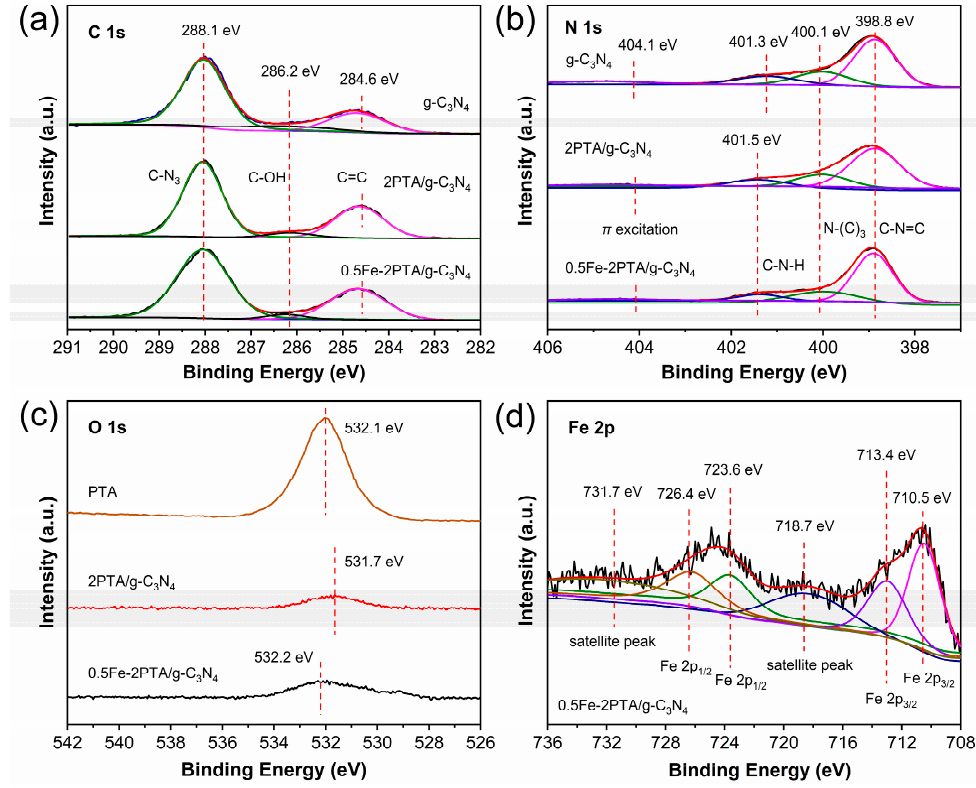
Figure 4. XPS spectra of samples: ( a ) C1s, ( b ) N1s, ( c ) O 1s and ( d ) Fe 2p. As shown in Figure 4c, compared with that of PTA, the O 1s peak of 2PTA/g-C 3 N 4 moves to a lower binding energy, indicating the increased electron density around the O atoms of PTA and confirming the hydrogen bond interaction between the -NH 2 of g-C 3 N 4 and the -COOH of PTA, combined with the above result of the C-N-H peak shift (Figure 4b). Interestingly, compared with that of the 2PTA/g-C 3 N 4 , the O 1s peak of 0.5Fe-2PTA/g-C 3 N 4 exhibits a moderate shift to the higher binding energy direction, indicating the decreased electron density around the O atoms of PTA due to the coordination bond interaction between the introduced Fe(III) and the -COOH of PTA. The interaction between the Fe(III) and the -COOH of PTA was also verified by the O 1s peaks of the PTA and 0.5Fe-PTA in Figure S5b, which clearly shows the O 1s peak shift of the PTA from 532.1 eV to 532.4 eV after introducing the Fe(III) [53]. It is worth noting that in Figures 4c and S5b, the O 1s peaks of the 0.5Fe-2PTA/g-C 3 N 4 and 0.5Fe-PTA are higher than those of the 2PTA/g-C 3 N 4 and PTA, respectively, which is due to the -OH of the introduced Fe(III). The Fe 2p spectra of 0.5Fe-2PTA/g-C 3 N 4 (Figure 4d) can be fitted with Fe 2p 3/2 peaks at 710.5 eV and 713.4 eV and the corresponding symmetric peaks of Fe 2p 1/2 at 723.6 eV and 726.4 eV, respectively, while the peaks at 718.7 eV and 731.7 eV are ascribed to the Fe(III) satellite peak [35,48]. These are characteristic of Fe 3+ , further confirming the existence of Fe(III) in 0.5Fe-2PTA/g-C 3 N 4 . To further explore the change of the Fe 2p peaks caused by the interaction between Fe(III) and the -COOH of PTA, the Fe 2p spectra of 0.5Fe-2PTA, 0.5Fe-g-C 3 N 4 and 0.5Fe-2PTA/g-C 3 N 4 were also analyzed. As shown in Figure S5c, compared with those of 0.5Fe-g-C 3 N 4 , the Fe 2p peaks of 0.5Fe-PTA move to a smaller direction, demonstrating that the interaction of Fe(III) with the -COOH of PTA results in an increase in the electron cloud density around the PTA’s Fe atoms [54]. Compared with the 0.5Fe-PTA, slightly more obvious shifts to a smaller direction are observed in 0.5Fe-2PTA/g-C 3 N 4 , which may be attributed to the influence of the hydrogen bonds between the -COOH of PTA and the -NH 2 of g-C 3 N 4